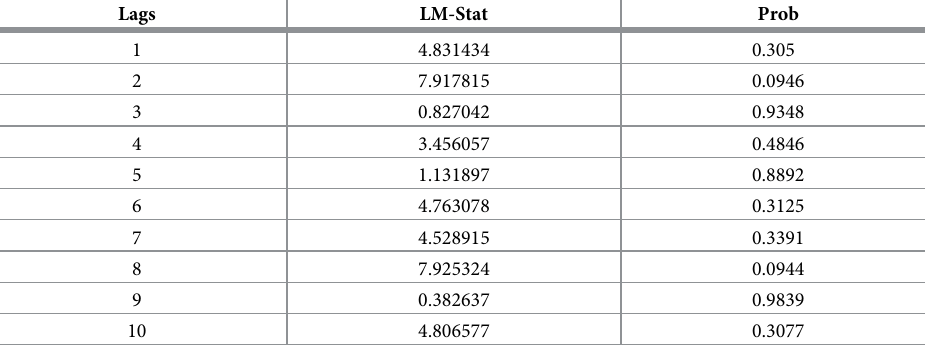
Table 16. Serial correlation LM test for Swiss data when P = 1 (Fisherian